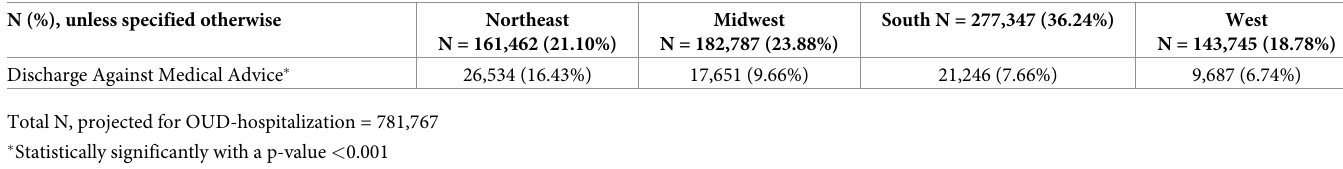
(Table 3; Fig 1). The mortality rate for OUD hospitalization was 1.2 per 100,000 NIS hospitali- zations in the U.S. in 1998–2000 that increased 5-times to 5.9 per 100,000 NIS hospitalizations Among the OUD hospitalizations, the mortality rate increased from 19.8 per 1,000 OUD comparison, mortality rate decreased for non-OUD hospitalizations over the same period from 23.8 to 19 per 1,000 non-OUD hospitalizations (Fig 2). Time-related increase in OUD hospitalizations and associated mortality was seen in all age groups, both sexes and in both white and non-white race/ethnicity ( data available on request ). over the study period, with the mean (median) total hospital charges increased from $8,261